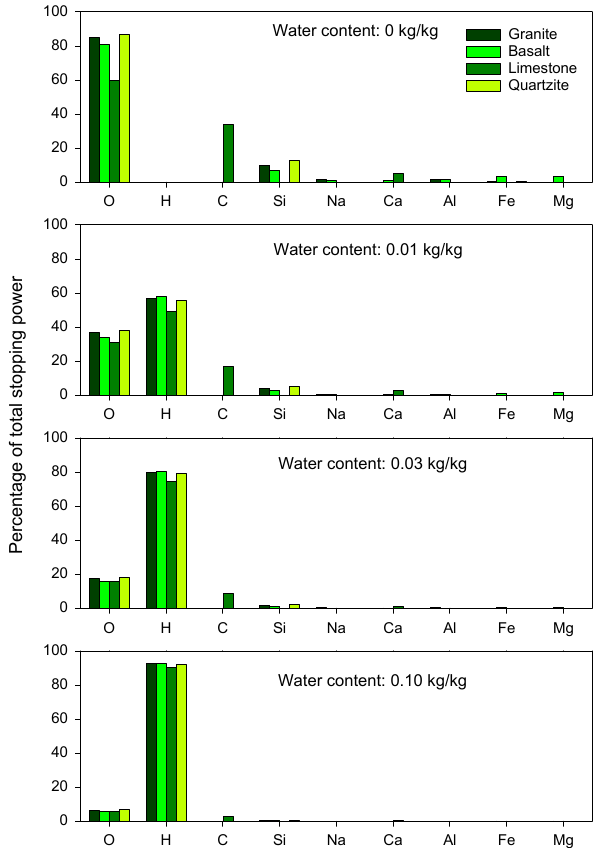
Fig. 5. Fractions of total stopping power in four common rocks contributed by the eight most important rock-forming elements and hydrogen, at four water contents. In all rocks, hydrogen becomes the most important moderating element at water content as low as 0.01kgkg − 1